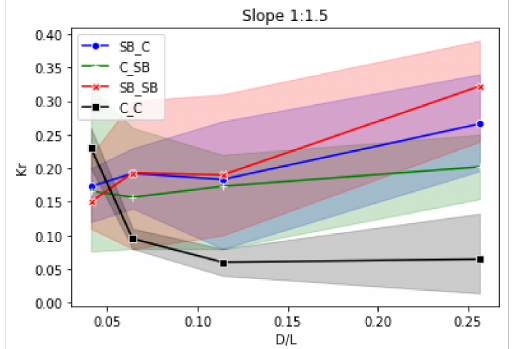
Figure 9. Kr vs. D/L for slope 1:1.5.